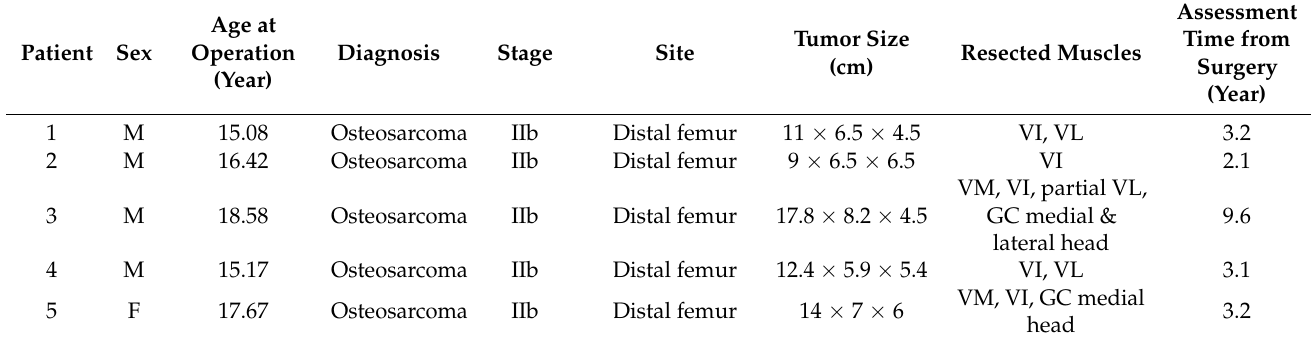
Table 1. Patient characteristics at the time of